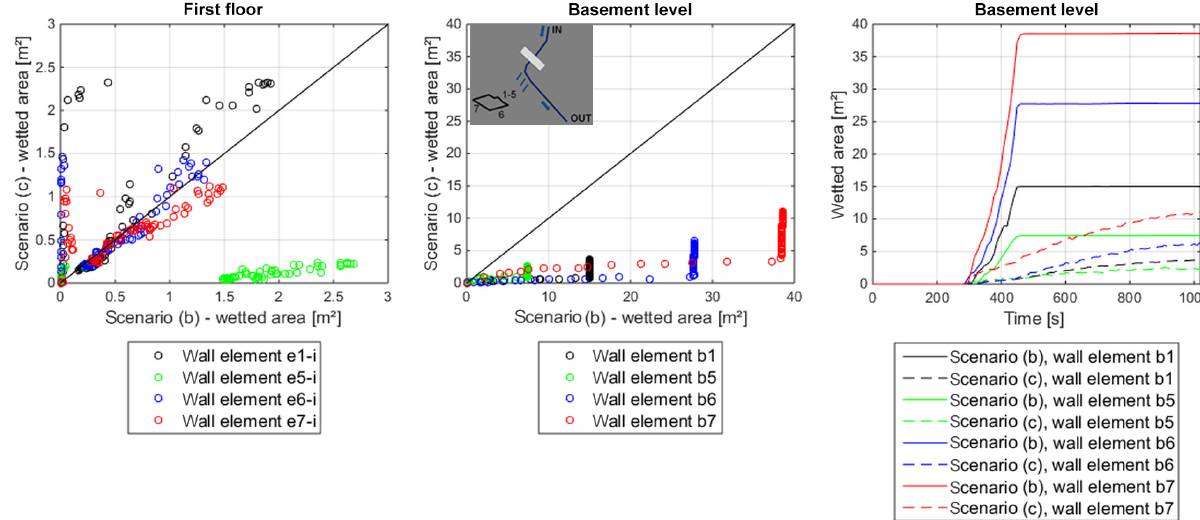
Figure 10. Comparison of wetted areas (m 2 ) during the simulations of the scenarios (b) and (c) – (left) wall elements e1, e5, e6, e7 on the first floor inside the building; (middle) wall elements b1, b5, b6 and b7 on the basement level (simulation results with output time steps à 10s); (right) temporal characteristics of wetting for the wall elements on the basement level for the scenarios (b) and